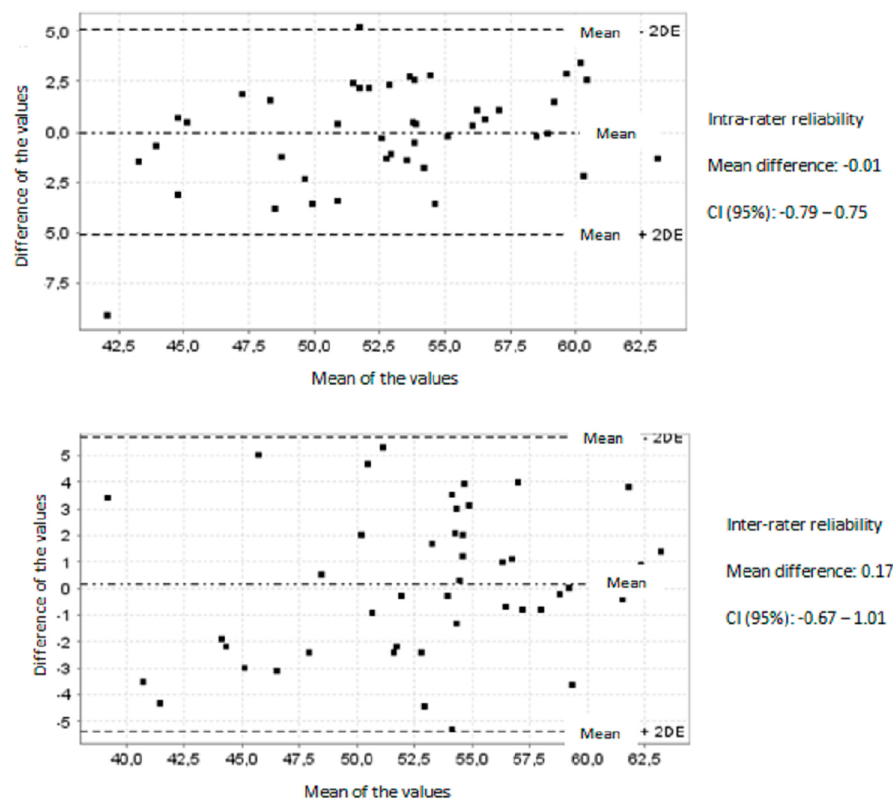
Figure 1. Bland and Altman chart for intra- and inter-observer reliability. Table 3. FHPapp criterion validity. Table 2. Intra- and inter-observer reliability.